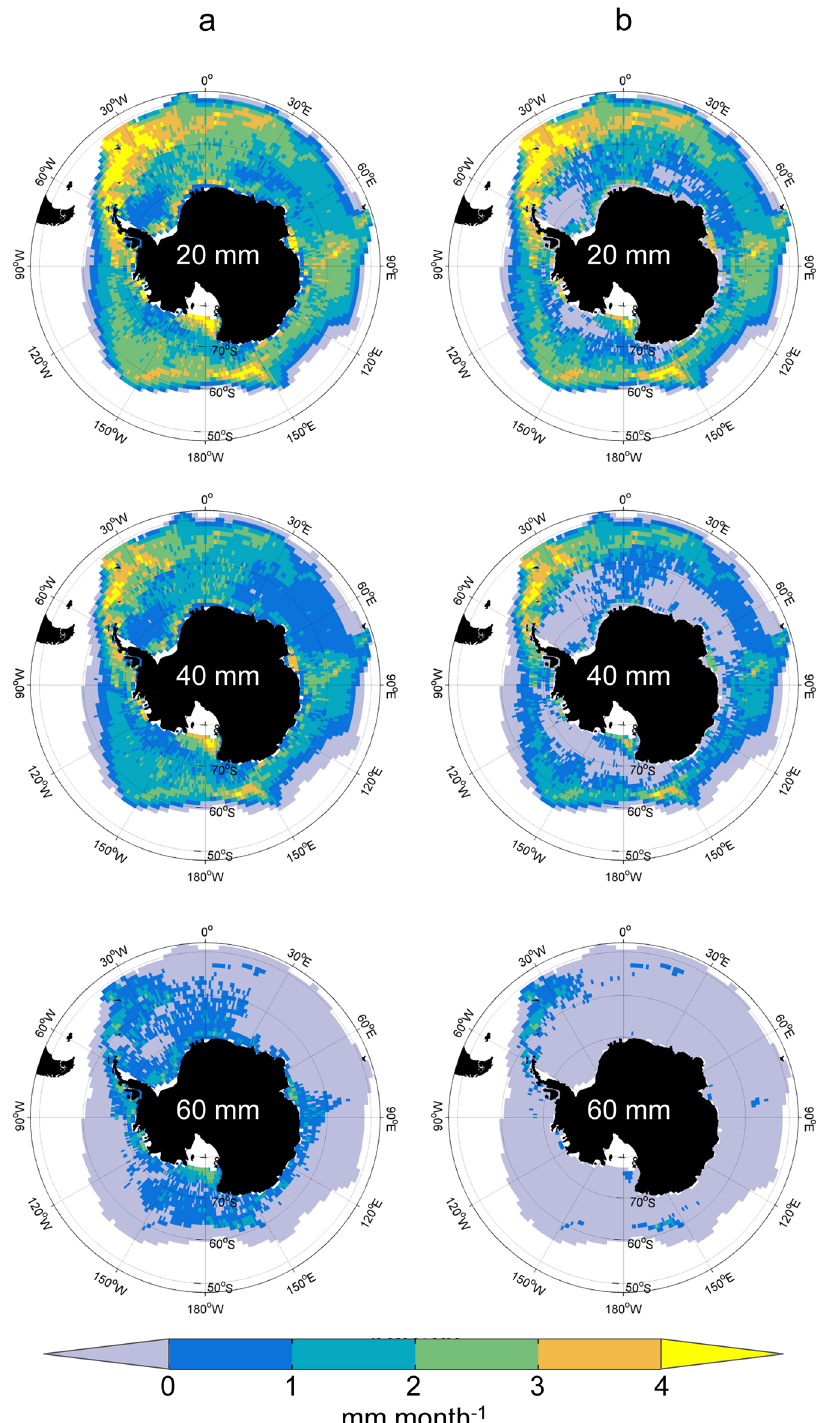
Figure 3. Mean monthly potential growth rate for increasing krill size calculated from September to April (mm month − 1 ) for two different assumptions about missing chlorophyll a data. Panel a plots based on assumption that missing chlorophyll a data are periods of 0 mm month − 1 growth. Panel b plots based on assumption that missing chlorophyll a data signifies a value of 0 mg chl a m − 3 . Only cells where each monthly temperature < 5 °C are used (see also Fig. 1). Figure created with Matlab software version R2013a (www.mathworks.com) using M_Map mapping toolbox version 1.4f